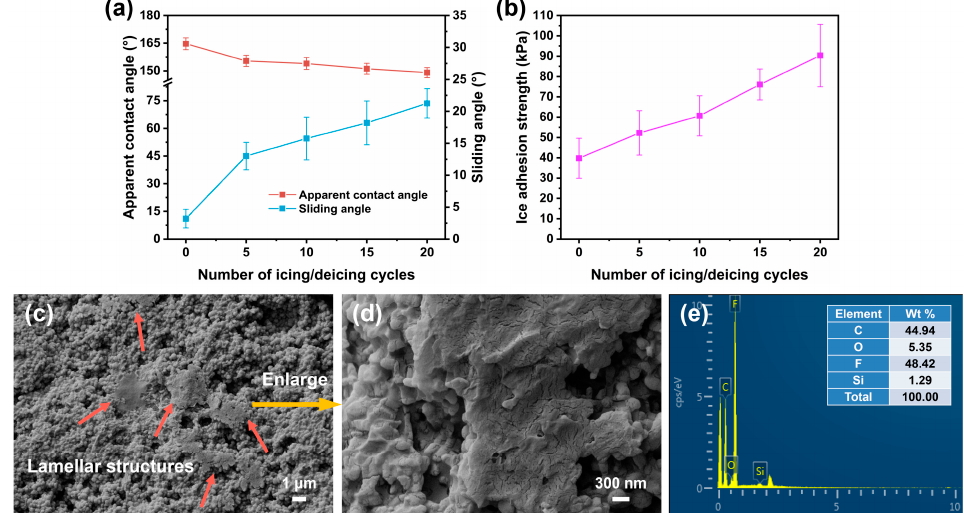
Figure 9. Wettability ( a ), ice-adhesion strength ( b ), micromorphology ( c , d ) and EDS spectrum ( e ) of 47.2% mass fraction coating after icing–deicing cycles.